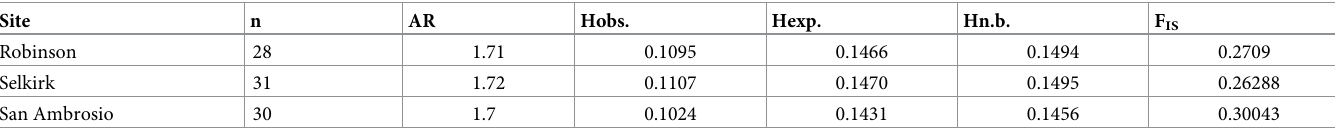
Table 1. Summary of data used in the analysis of the sea urchin C . sylviae including sample size (n), allelic richness (AR) observed heterozygosity (Hobs.), expected heterozygosity (Hexp.), non-biased heterozygosity (Hn.b.) and F IS at each study site. Site n AR Hobs. Hexp.